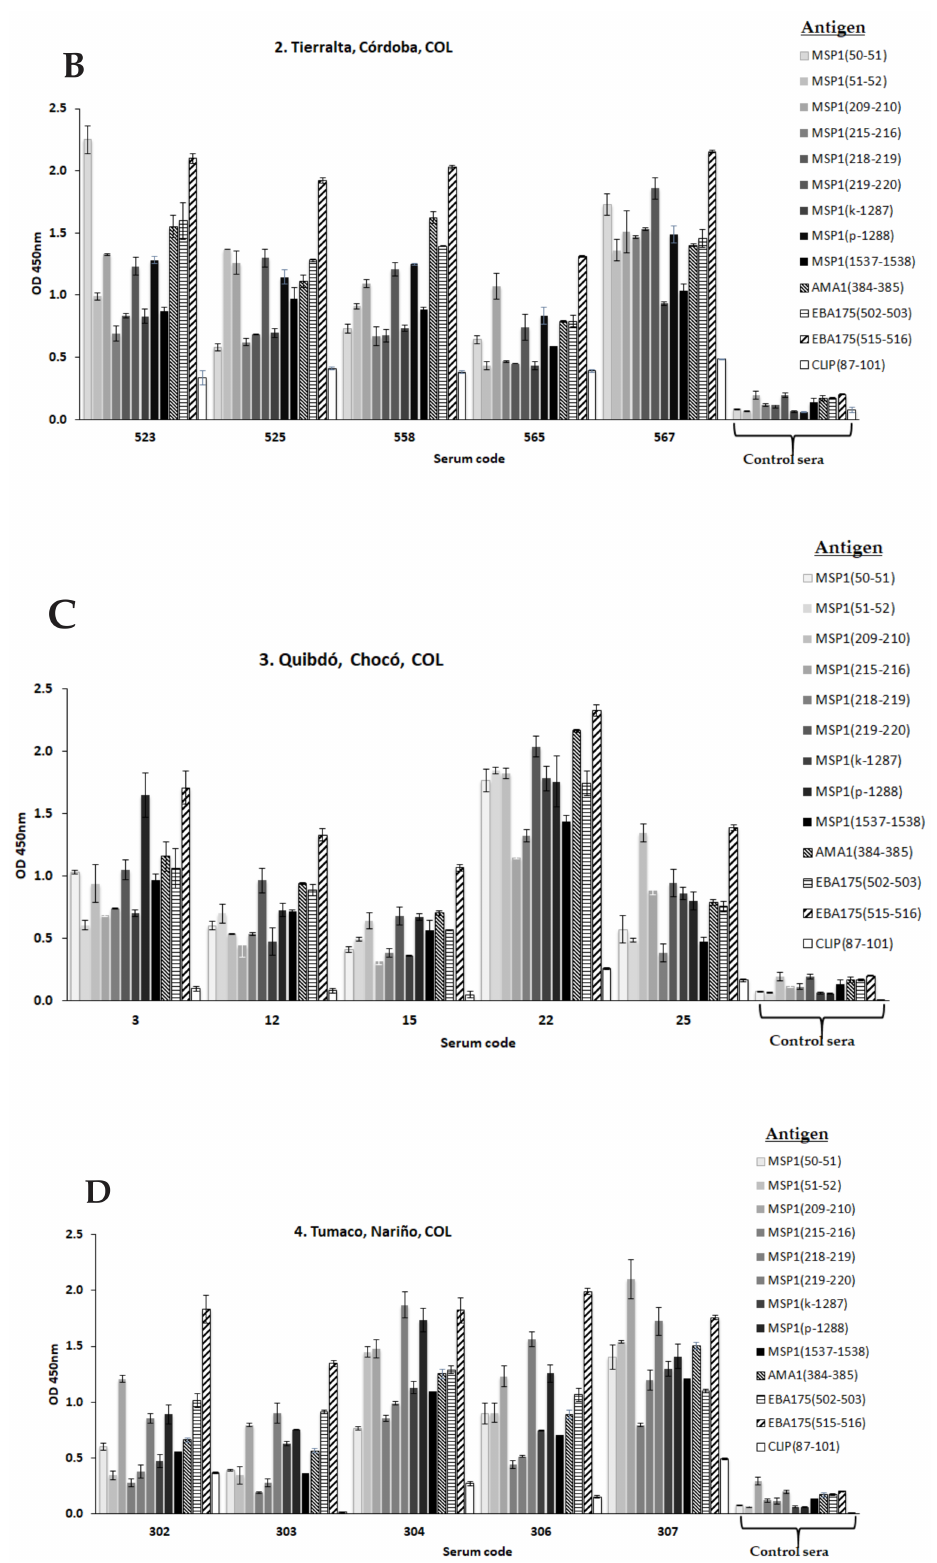
Figure 5. Selected human sera recognizes designed modified-epitope antigens of Plasmodium spp. by ELISA tests. ( A ) Samples from San Juan de Nepomuceno village (Bolivar) ( B ) Samples from Tierralta (Cordoba). ( C ) Samples from Quibd ó (Choc ó ) and ( D ) Samples from Tumaco (Nariño). Human sera from a malaria non-endemic areas were obtained from Bogot á DC and used as negative controls. The CLIP endogenous peptide was employed as a non-relevant